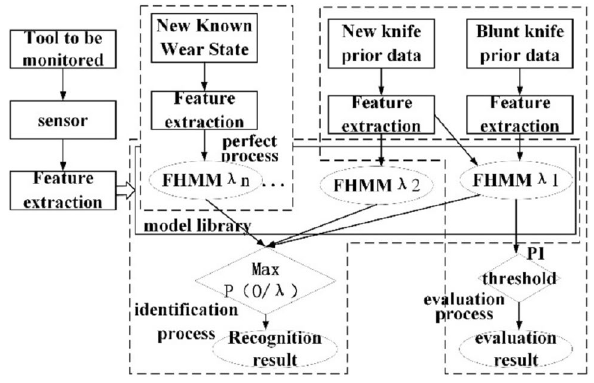
Fig. 8 Hidden Markov model monitoring system